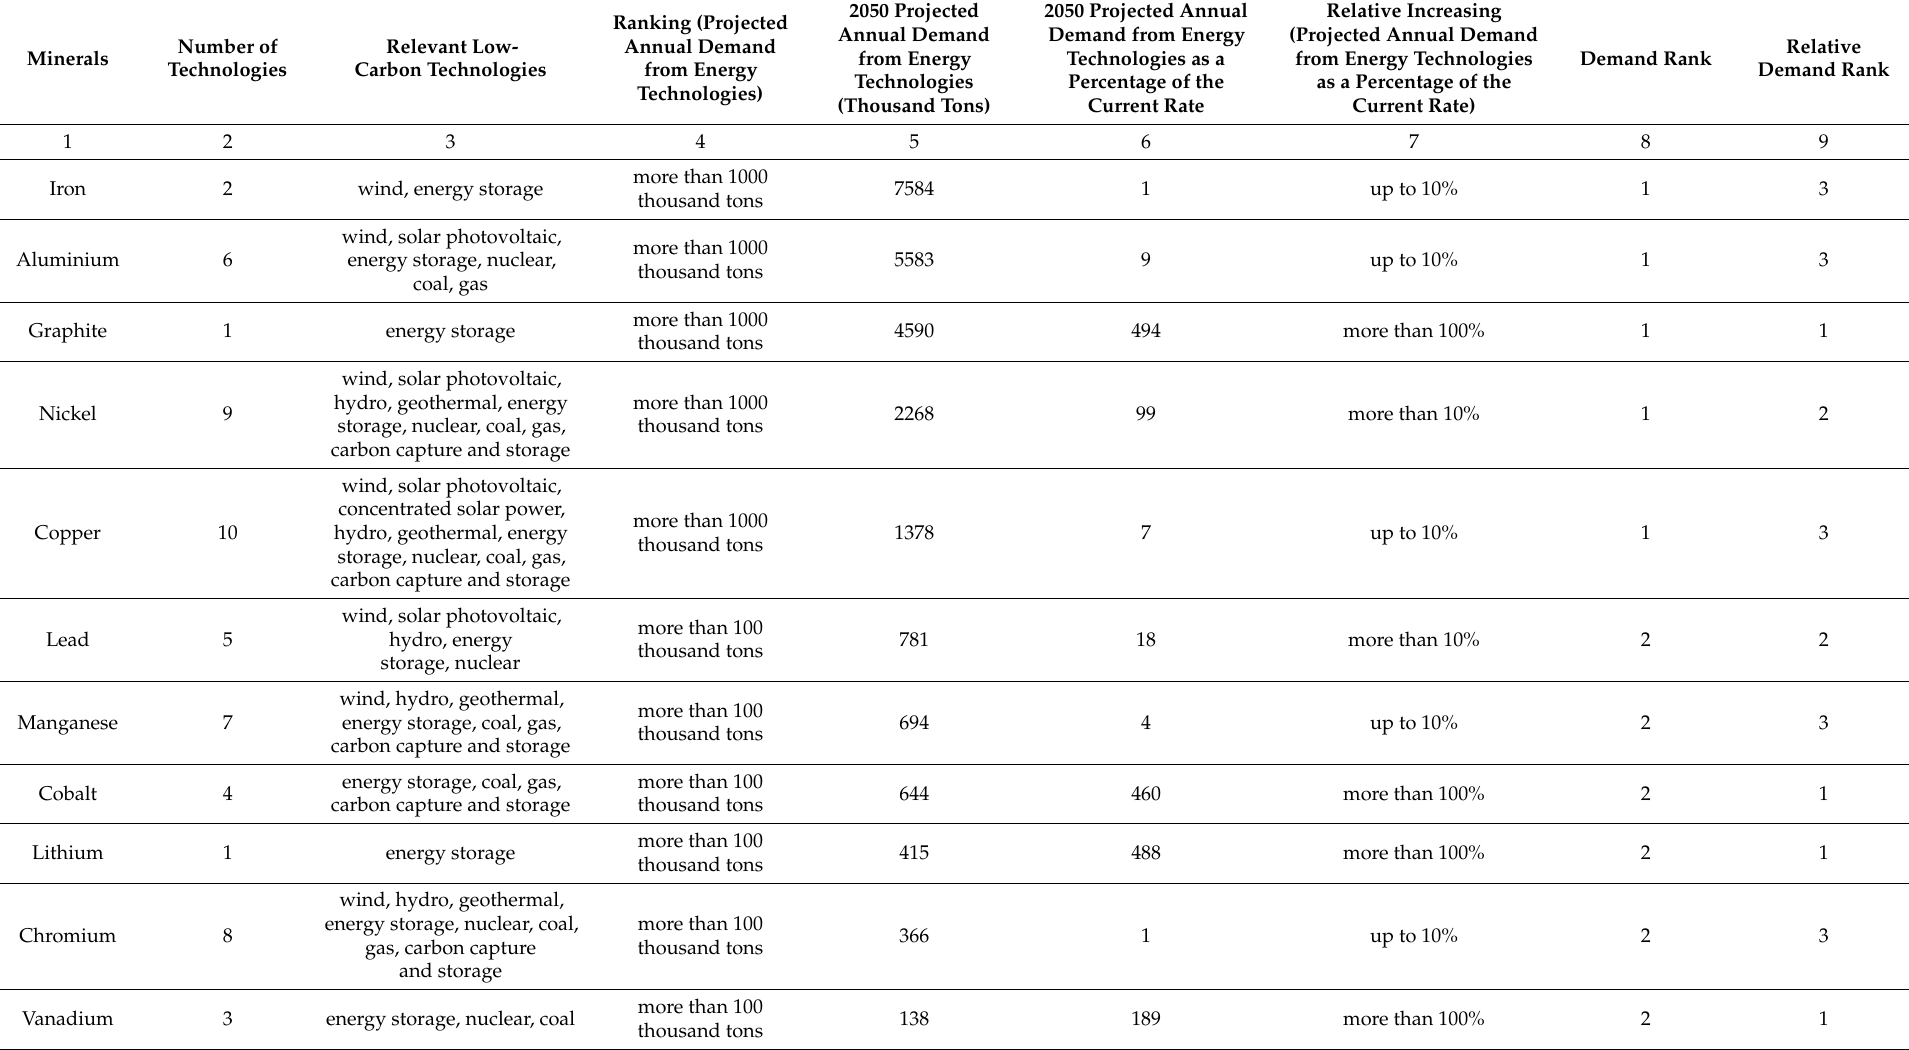
Table 2. Initial data for calculating the availability indices IA1, IA2 and